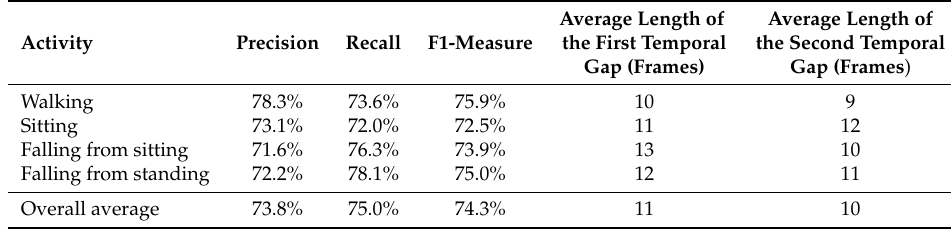
Table 8. Recognition results of the four fall-related activities from partially-observed videos with two unobserved video subsequences between the beginning and the end of each testing video